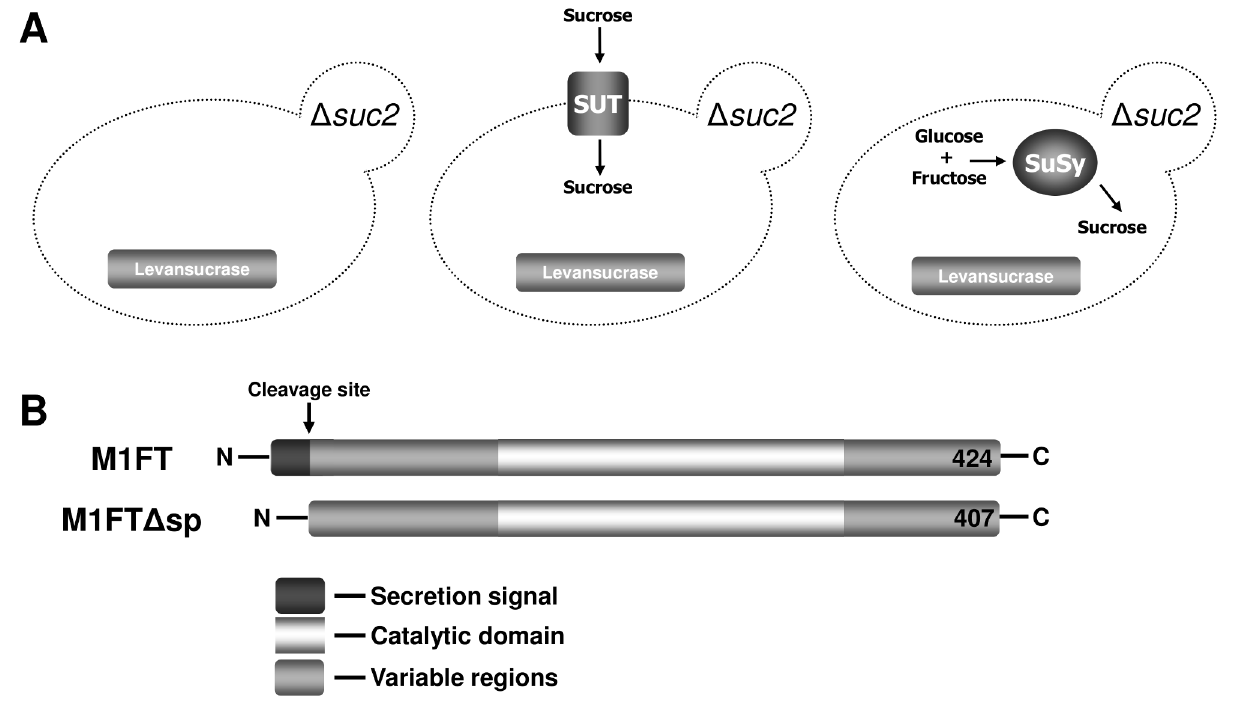
Figure 1. Diagrammatic representation of experimental layout and levansucrases used in this study. (A) Yeast strains used to express the levansucrase M1FT; BY4742Δ suc2 and the two sucrose accumulating strains BY4742Δ suc2 -SuSy and BY4742Δ suc2 -SUT. (B) M1FT, a levansucrase from Leuconostoc mesenteroids and also a truncated version of M1FT, without its predicted secretion signal, was expressed in the different yeast